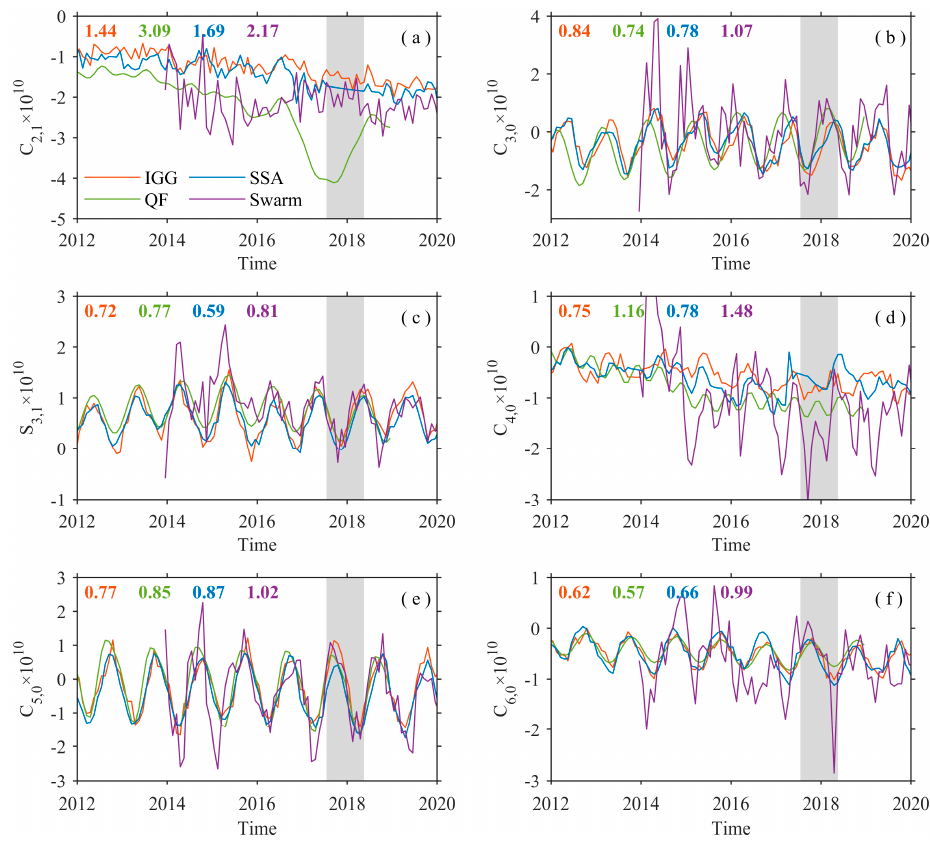
Figure 2. Time series of selected coefficients of the IGG, SSA, QF, and Swarm data: ( a ) C 2,1 , ( b ) C 3,0 , ( c ) S 3,1 , ( d ) C 4,0 , ( e ) C 5,0 , ( f ) C 6,0 . The upper left values are the RMS values for IGG, SSA, QF, and Swarm, respectively.